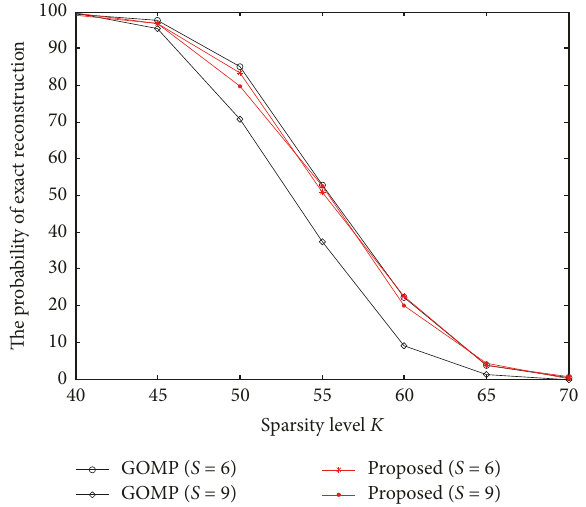
Figure 3: Reconstruction performance of GOMP and the proposed method with a large 𝑆